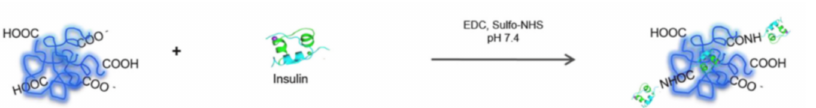
Figure 15. Conjunction of insulin with nanogels through amide bonds. Adapted with permission from [26]; published by Elsevier,